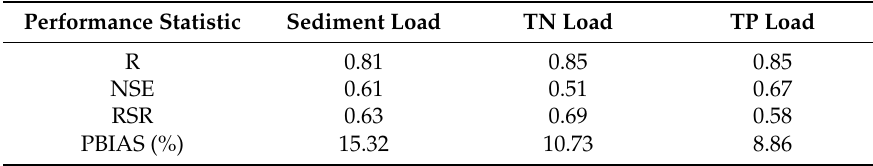
Table 5. Performance measures of water quality calibration at the watershed